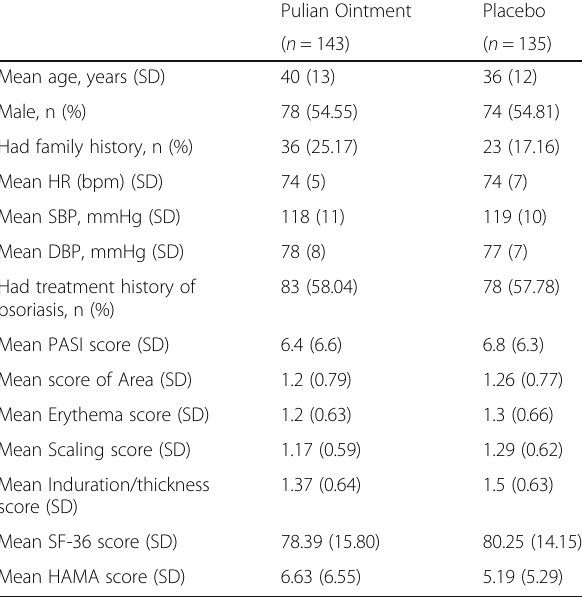
Table 1 Baseline characteristics of